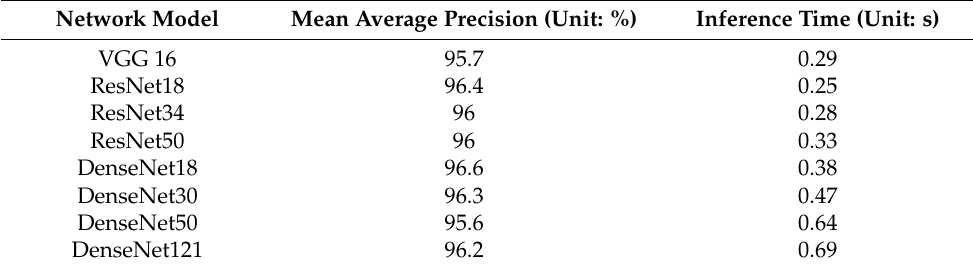
Table 7. Performance for the